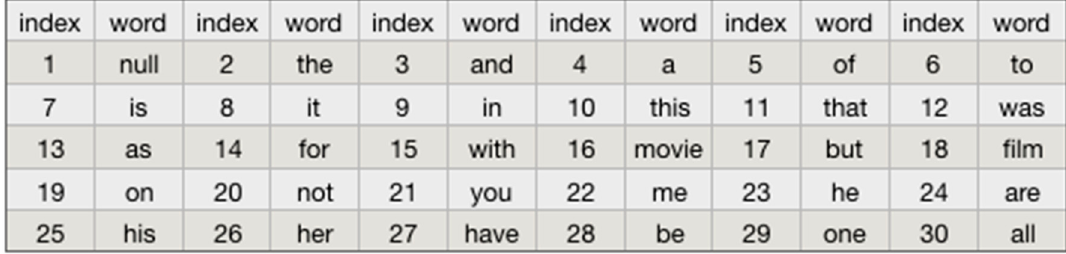
Figure 5. Data set Word Frequency Dictionary (part).